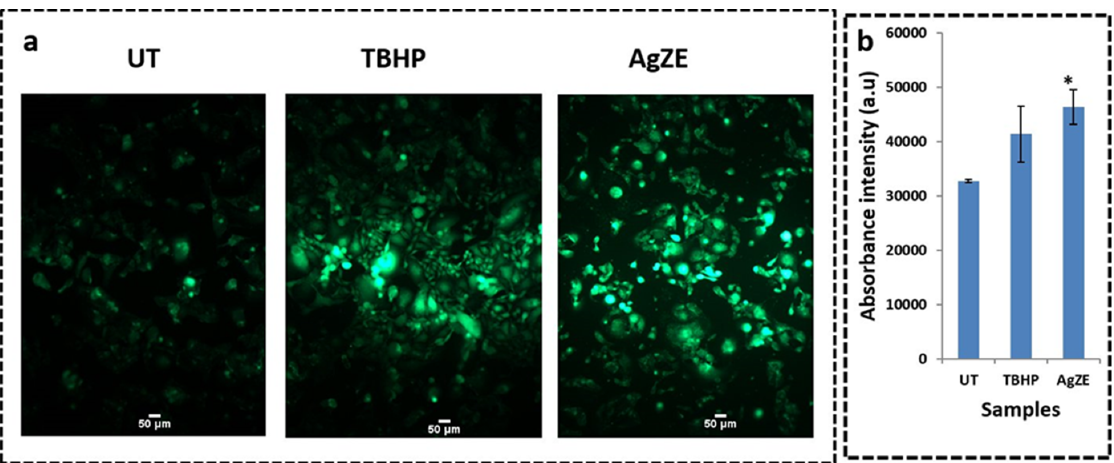
Figure 6. ( a ) Determination of the intracellular ROS (H 2 O 2 ) production in U-87 cell line using DCFDA reagent after treat- ment with AgZE (IC50: 4.1 µL) and Tertiary-Butyl hydroperoxide: TBHP (positive control) for 5 h, ( b ) graphical represen- tation of quantification of ROS generation. Higher amounts of hydrogen peroxide production is observed upon treatment with the AgZE compared to untreated (UT) cells. These experiments are performed thrice and represented as mean ± SD. Significant differences from untreated (UT) cells are observed (* p < 0.05).